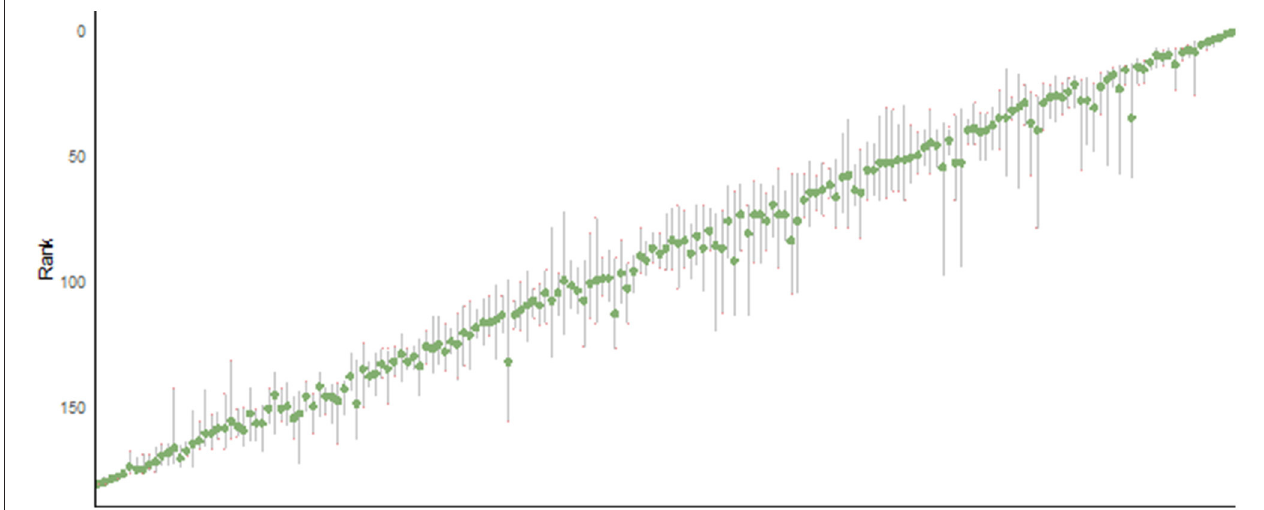
FIGURE 6 | 90% confidence intervals on ranks of the WEF Nexus Index. The gray bars are the 90% confidence intervals. Countries are ordered according to their nominal rank. The green point is the median rank across the uncertainty analysis.